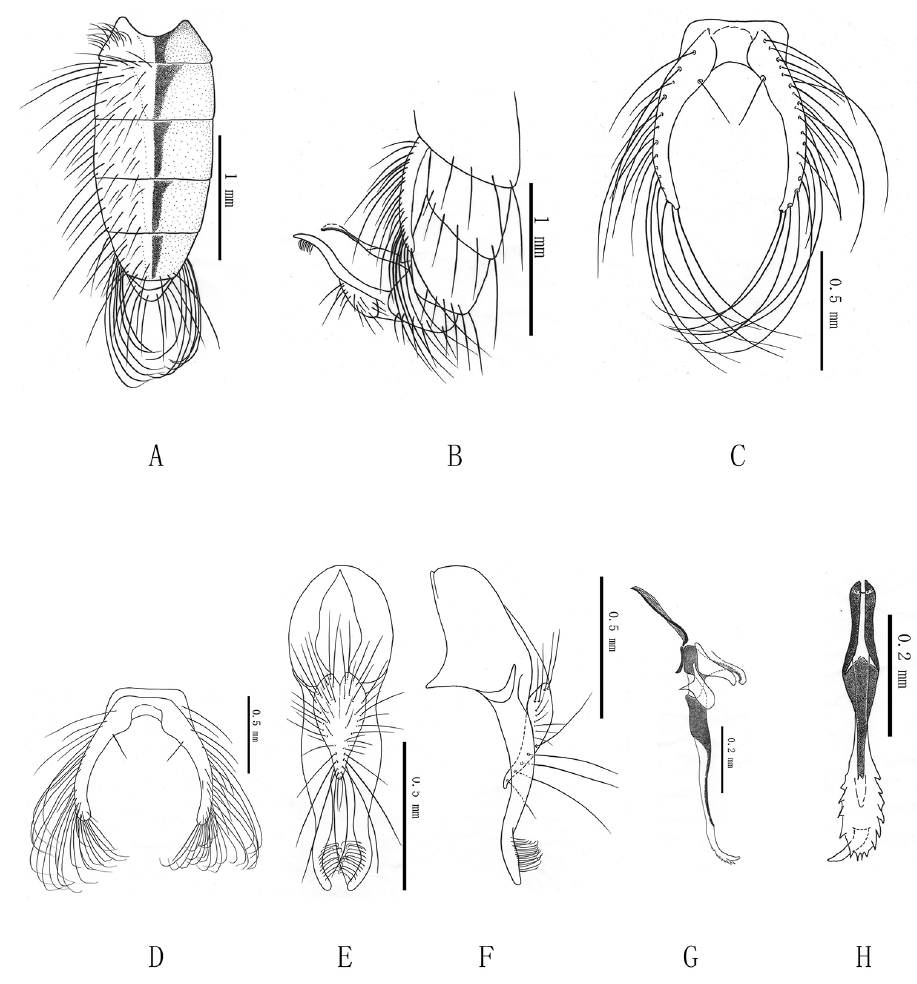
Figure 1. Delia dentiaedeagus sp. n. A male, abdomen in dorsal view B male, distal half of abdomen in profile C male, 5th sternite in ventral view, in holotype D male, 5th sternite in ventral view, in paratype E male, terminalia in posterior view F male, terminalia in profile G male, aedeagus in profile H male, distal part of aedeagus in anterior